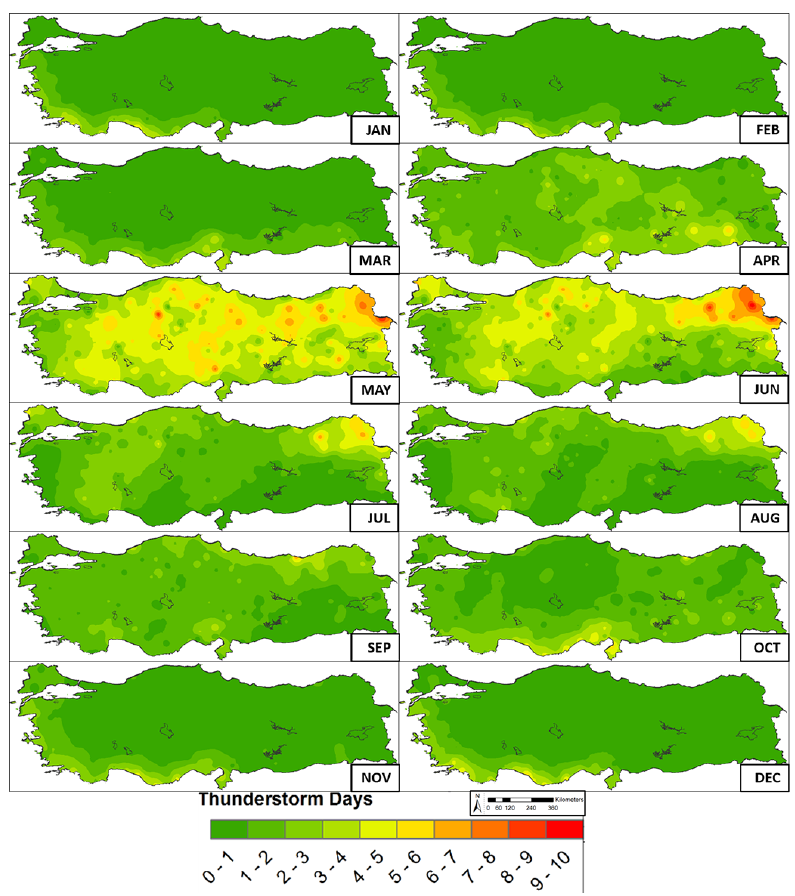
Figure 2. Average number of thunderstorm days in Turkey for each month. Data were provided by the Turkish State Meteorological